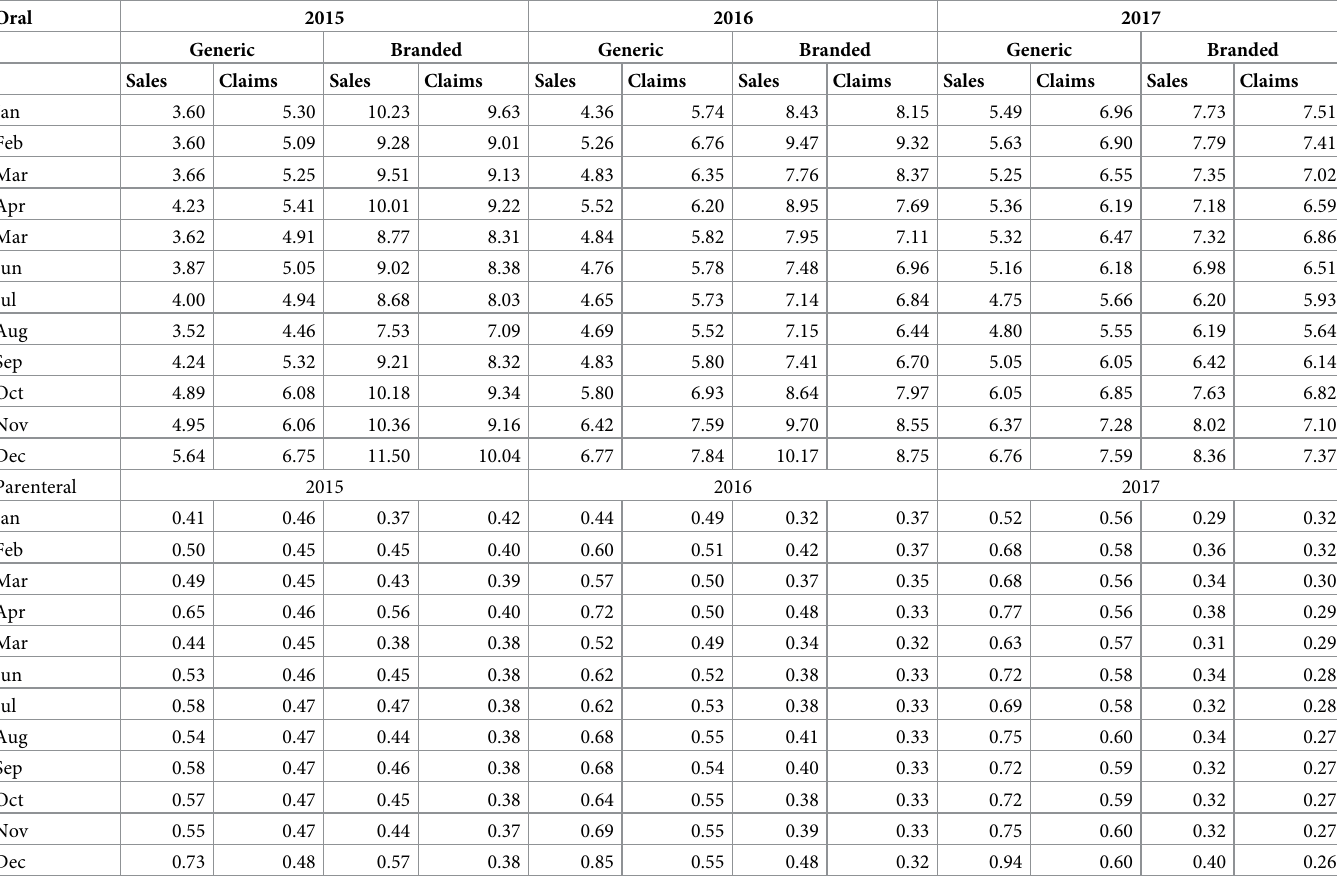
Table 2. Temporal trends in generic and branded antimicrobial use according to sales and claims data from 2015 to 2017.